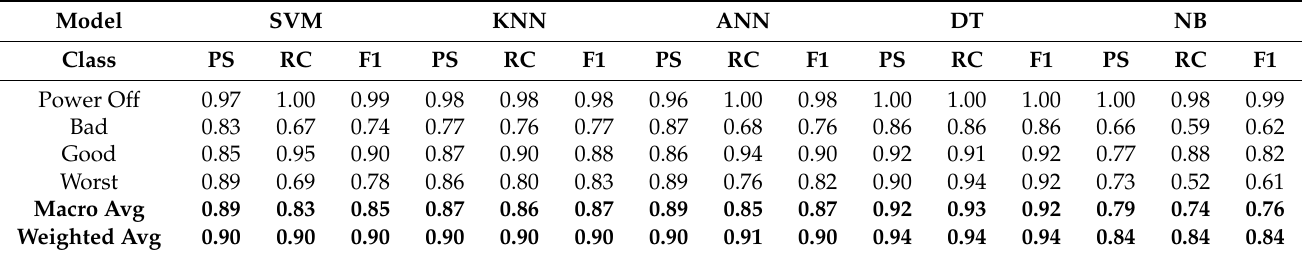
Table 9. The comparative effectiveness of Target based on complete hyperparameter tuning.